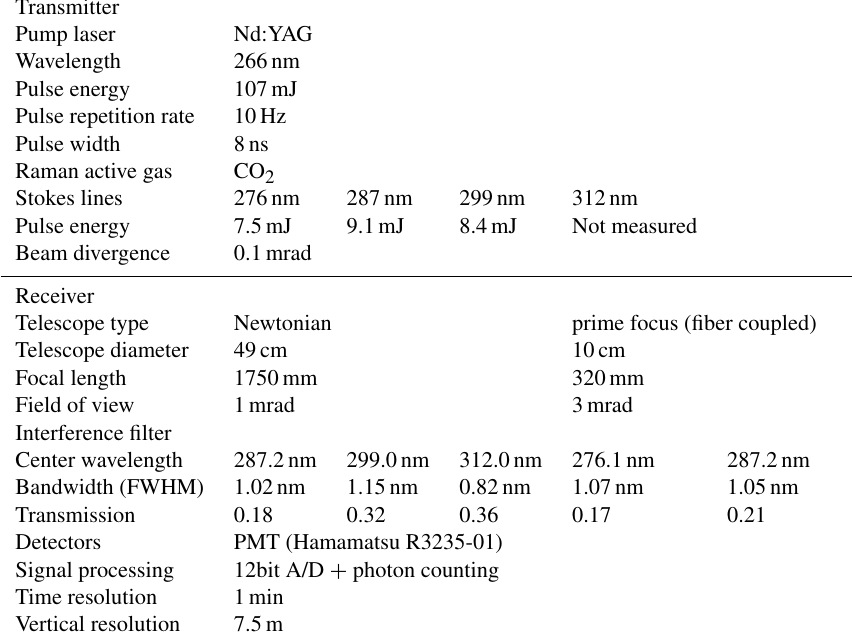
Table 2. Characteristics of the tropospheric ozone DIAL system.